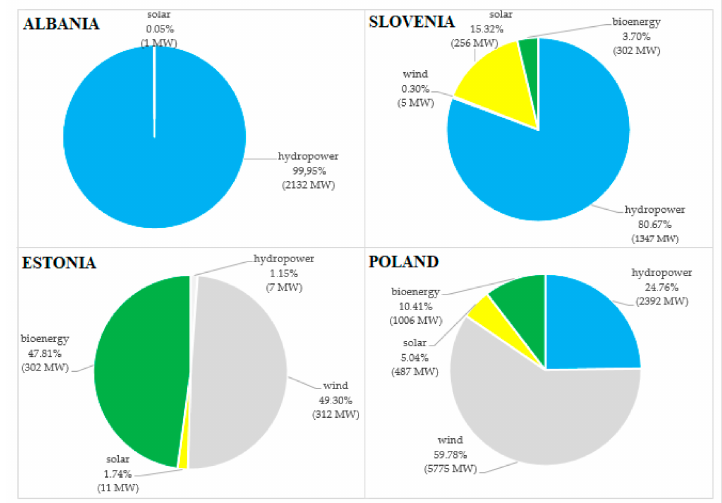
Figure 6. Percentage of renewable energy sources by installed capacity in Albania, Slovenia, Estonia, and Poland in 2018 (data based on